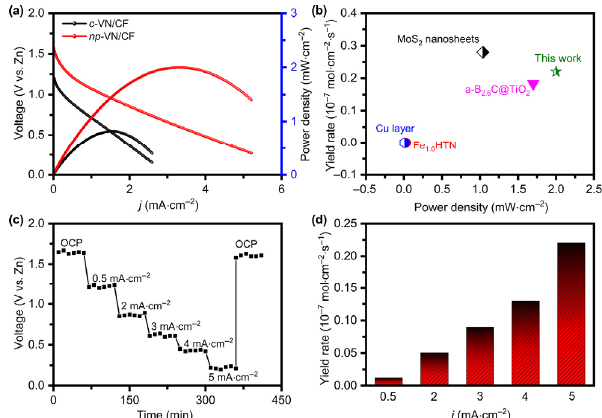
Figure 2 Electrochemical NORR performance of np -VN/CF in acid medium. (a) NORR polarization curves. j denotes the current density. (b) and (c) The calculated FE and NH 3 yield rate values for np -VN/CF and c -VN/CF. (d) Potentiostatic electrolysis in NO-/Ar-satuated electrolytes. (e) Chronoamperometry stability test at –0.6 V vs. RHE.